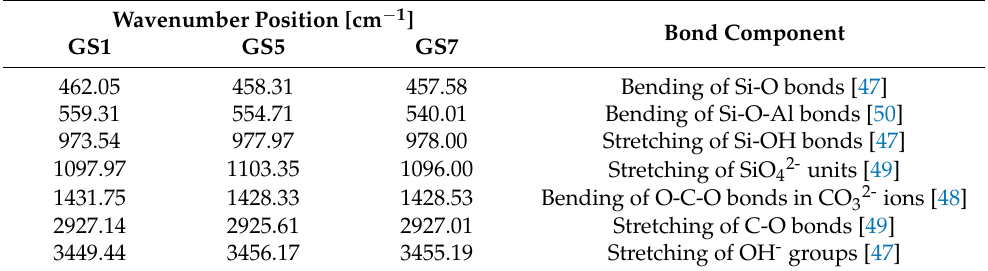
Table 6. FTIR absorbance peaks for GS